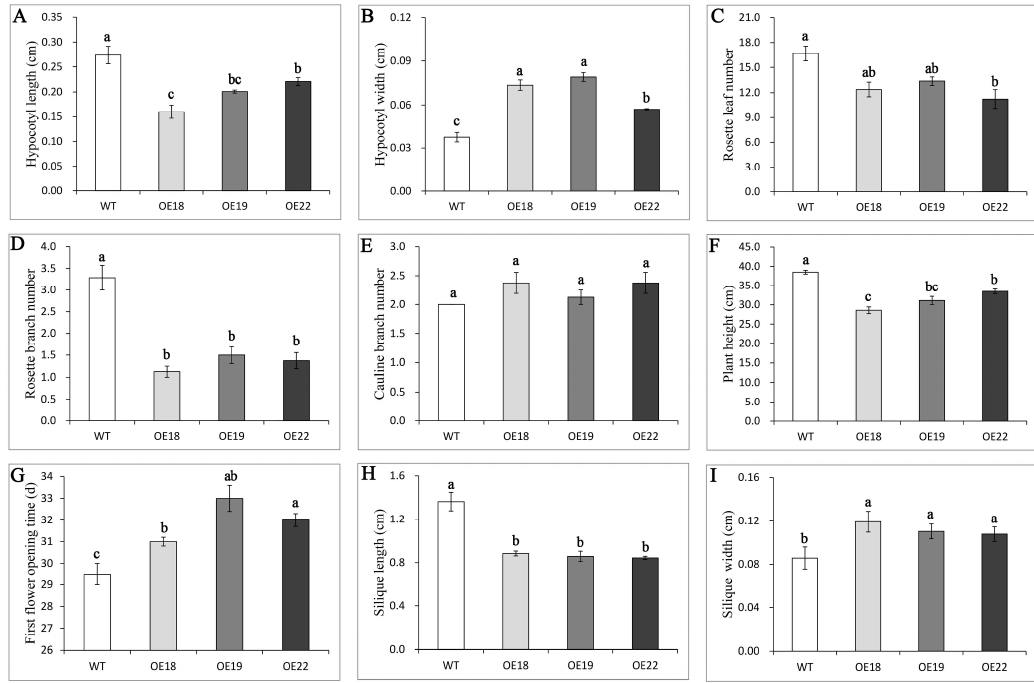
Figure 6. ( A , B ) Hypocotyl length and width of the T2 transgenic lines and WT in 7-day-old seedlings. ( C , D , E ) Rosette leaf number, rosette branch number, and cauline branch number in the transgenic and WT plants. ( F ) Plant height in the T2 transgenic lines and WT at 55 days after sowing. ( G ) First flower opening time in the T2 transgenic lines and WT. ( H , I ) Silique length and width in the T2 transgenic lines and WT. Error bars on each point indicate ± SE from at least five independent replicates. Di ff erent letters indicate significant di ff erences as determined using ANOVA, followed by Tukey’s HSD test ( p <